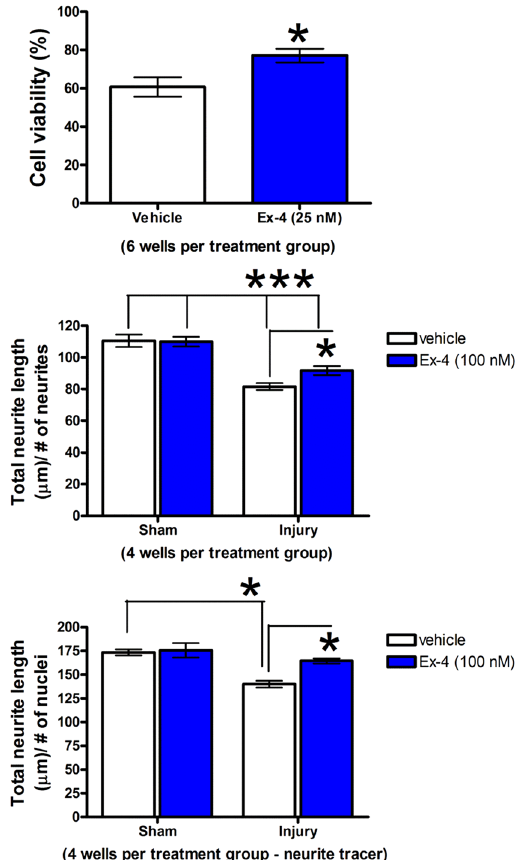
Figure 6. Effects of Ex-4 on HT22 cell viability and neurite length in an in vitro model of mild traumatic brain injury. Upper Panel: Treatment of injured HT22 cells with Ex-4 (25 nM) enhanced cell viability cells when compared to injured vehicle-treated cells ( * P < 0.05). Middle Panel: Cell injury induced significant reductions in neurite number-normalized neurite length in both vehicle and Ex-4 (100 nM) treated cells ( *** P < 0.001). However, treatment of injured HT22 cells with Ex-4 ameliorated had less injury-induced reductions in neurite number-normalized neurite length compared to vehicle treated injured cell ( * P < 0.05). Lower Panel: Cell injury induced a significant reduction in nuclei-normalized neurite length in vehicle injured cells ( * P < 0.05). Treatment of injured cells with Ex-4 (100 nM) prevented the injury-induced reduction in nuclei-normalized neurite length, and led to significant preservation of neurite length compared to vehicle treated injured cells ( * P < 0.05). Data are presented as a mean ± s.e.m. of measurements from 4 to 6 wells per treatment